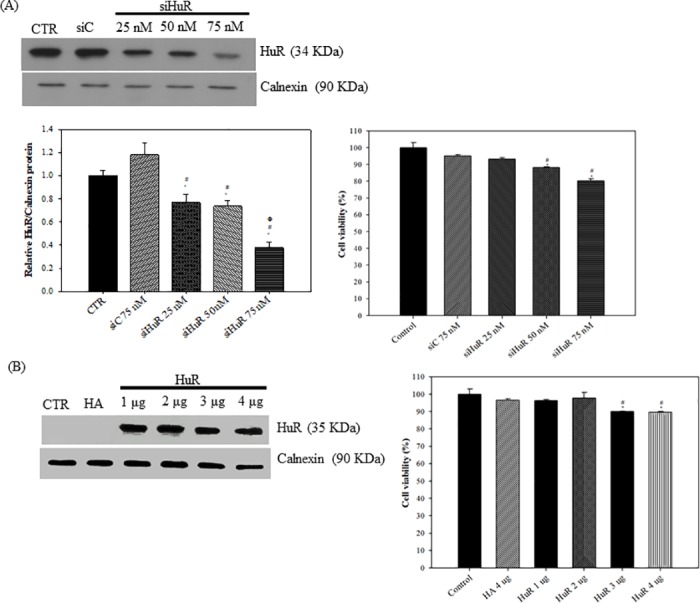
The effect of HuR expression levels on viability of SW620 cells.(A) The knockdown efficiency of siHuR and its effect on cell viability. SW620 cells were transfected with 75 nM of scramble siRNA (siC) or 0, 25, 50, 75 nM of siRNA against HuR (siHuR) for 48 h. Cells without transfection are designed as control (CTR). Proteins were then extracted for detection of HuR and Calnexin by western blotting (upper panel) and the quantification of relative HuR/Calnexin expressions was shown. Data are presented as means ± S.D. from three independent experiments (lower left panel). * P<0.05 compared to the control group; # P<0.05 compared to the siC group; Φ P<0.05 compared to siHuR 25 nM group. The effect of siHuR on the viability of SW620 cells were measured at 0, 25, 50, 75 nM of siHuR for 24 h. Viable cells were measured by MTT assay. The percentage of cell viability was calculated by setting the control group as 100%. Data are presented as means ± S.D. from three independent experiments (lower right panel). * P<0.05 compared to the control group; # P<0.05 compared to the siC group. (B) The overexpression efficiency of HuR and its effect on cell viability. Cells were transfected with pCDNA-HA (HA) 4 μg or 0, 1, 2, 3, 4 μg/ml of pCDNA-HA-HuR (HuR) for 48 h. Cells without transfection were designed as control. Proteins were then extracted for detection of HuR and Calnexin by western blotting (upper panel). The effect of HuR on the cell viability was measured at 0, 1, 2, 3, 4 μg/ml of HuR for 24 h. The viable cells were measured and analyzed as in (A). The plot was shown in the lower panel of (B). * P<0.05 compared to the control group; # P<0.05 compared to the HA group.